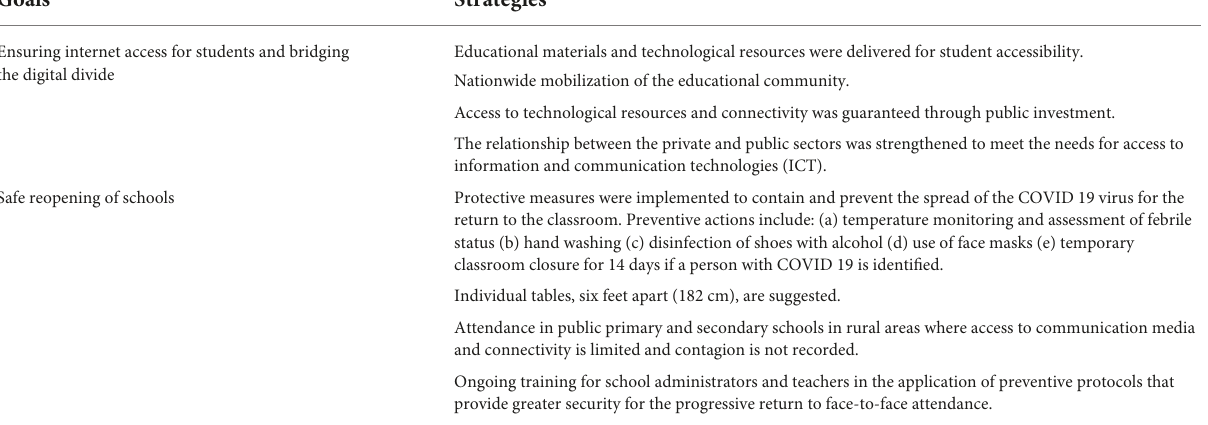
TABLE 2 Goals and strategies adopted by Latin American governments. Goals